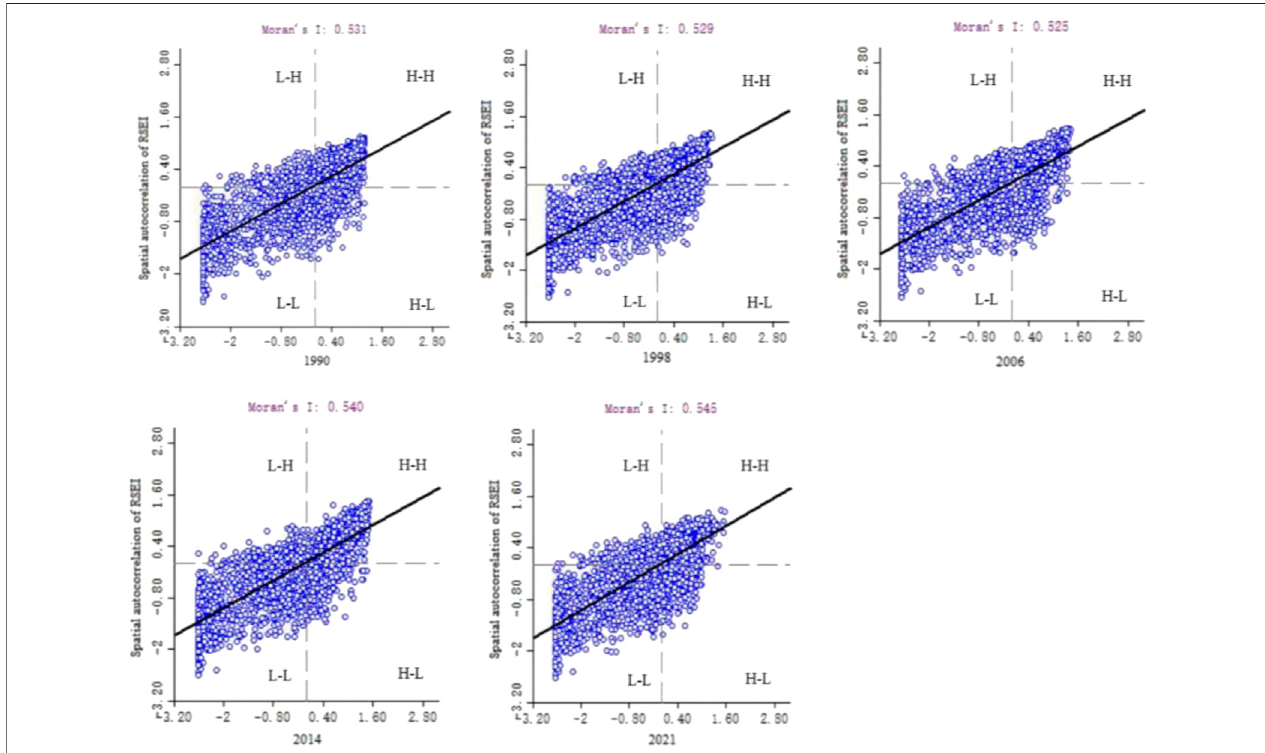
FIGURE 7 | Moran ’ s I of the RSEI on the Jianghan Plain from 1990 to